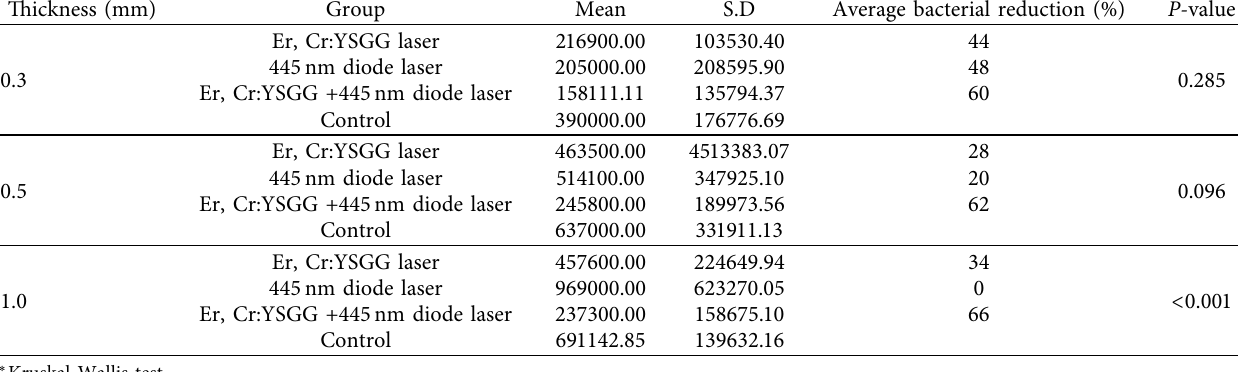
Table 1: Comparison of the number of bacteria in different groups with the same thickness.